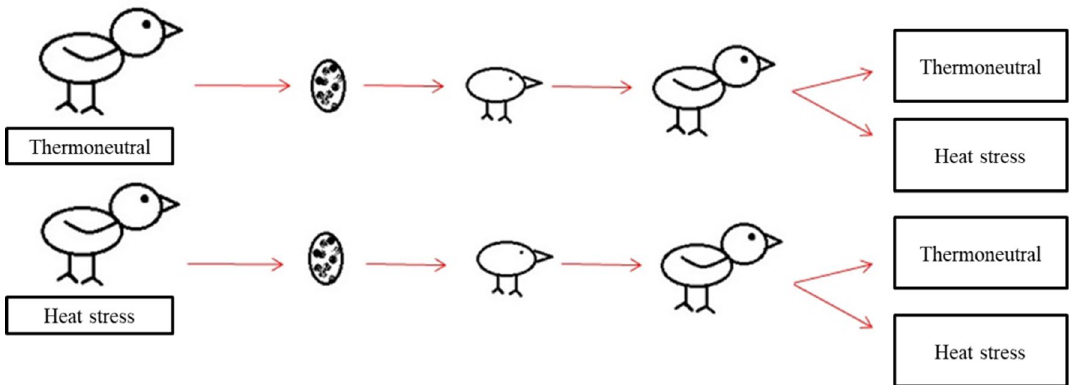
Figure 1. Schematic diagram of the experimental design. Eggs produced by quail layers exposed to thermoneutral and heat stress conditions were collected for 10 days and incubated under the same conditions. After hatching, chicks were raised under conventional conditions for 15 days. At 15 days of age, chicks were further divided into two groups: one half was raised under thermoneutral conditions (23 °C) and the other half under intermittent heat stress conditions (daily exposure to 34 °C for 6